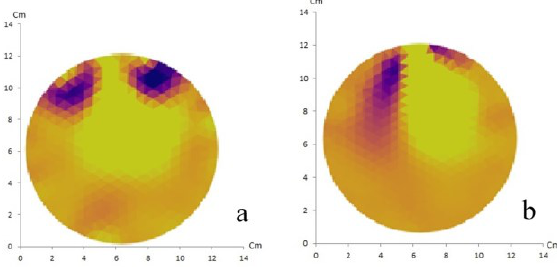
Fig.6: NOSER method with 16 electrodes (a) and 32 electrodes (b) of artificial solid tumor ion shows a match between the reconstructed image and the original object containing two